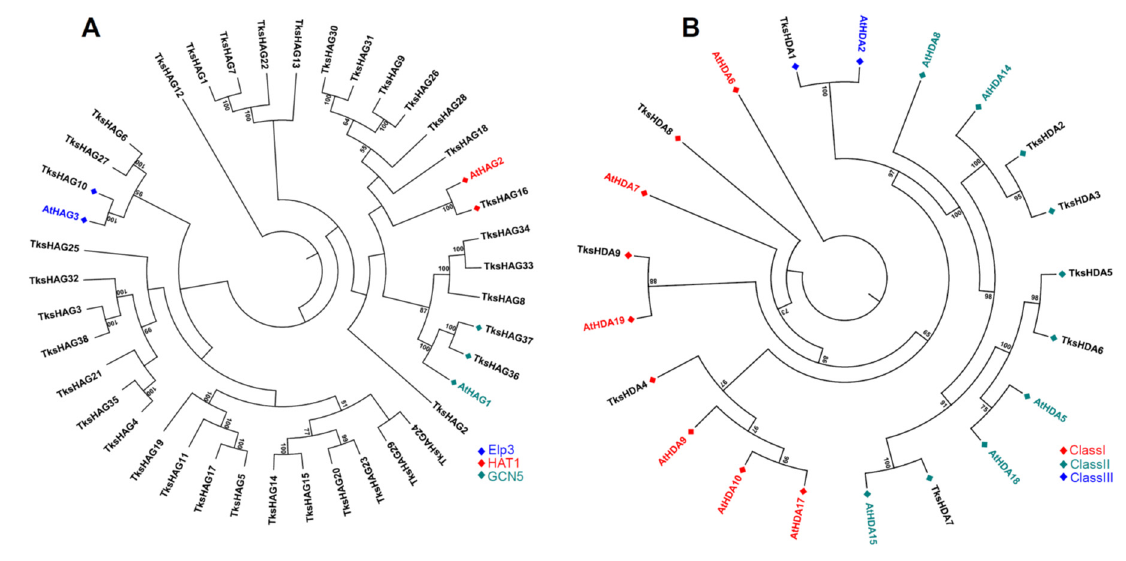
Figure 3. Phylogenetic tree of HAG ( A ) and HDA ( B ) proteins of Taraxacum kok-saghyz and Arabidopsis thaliana (in colour according to their respective classes). The numbers near the tree branches represent bootstrap values.